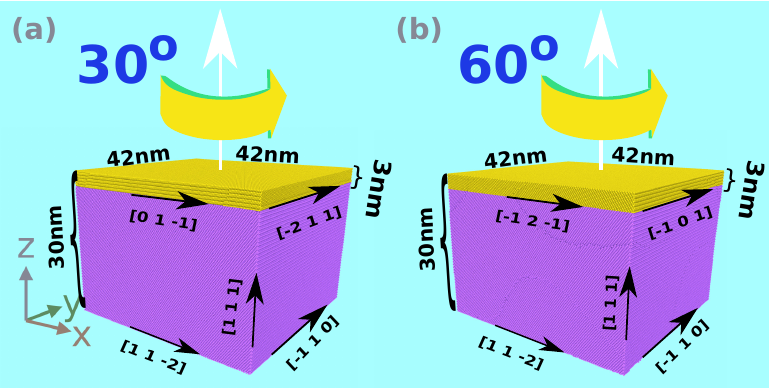
Figure 2. Crystallographic orientations of the grains in case of a ( a ) 30 ◦ and a ( b ) 60 ◦ twist boundary between the upper (yellow) and the lower (purple) Ni block. In both cases, the zigzag edge of graphene is aligned with the [ 11¯2 ] direction of the lower Ni